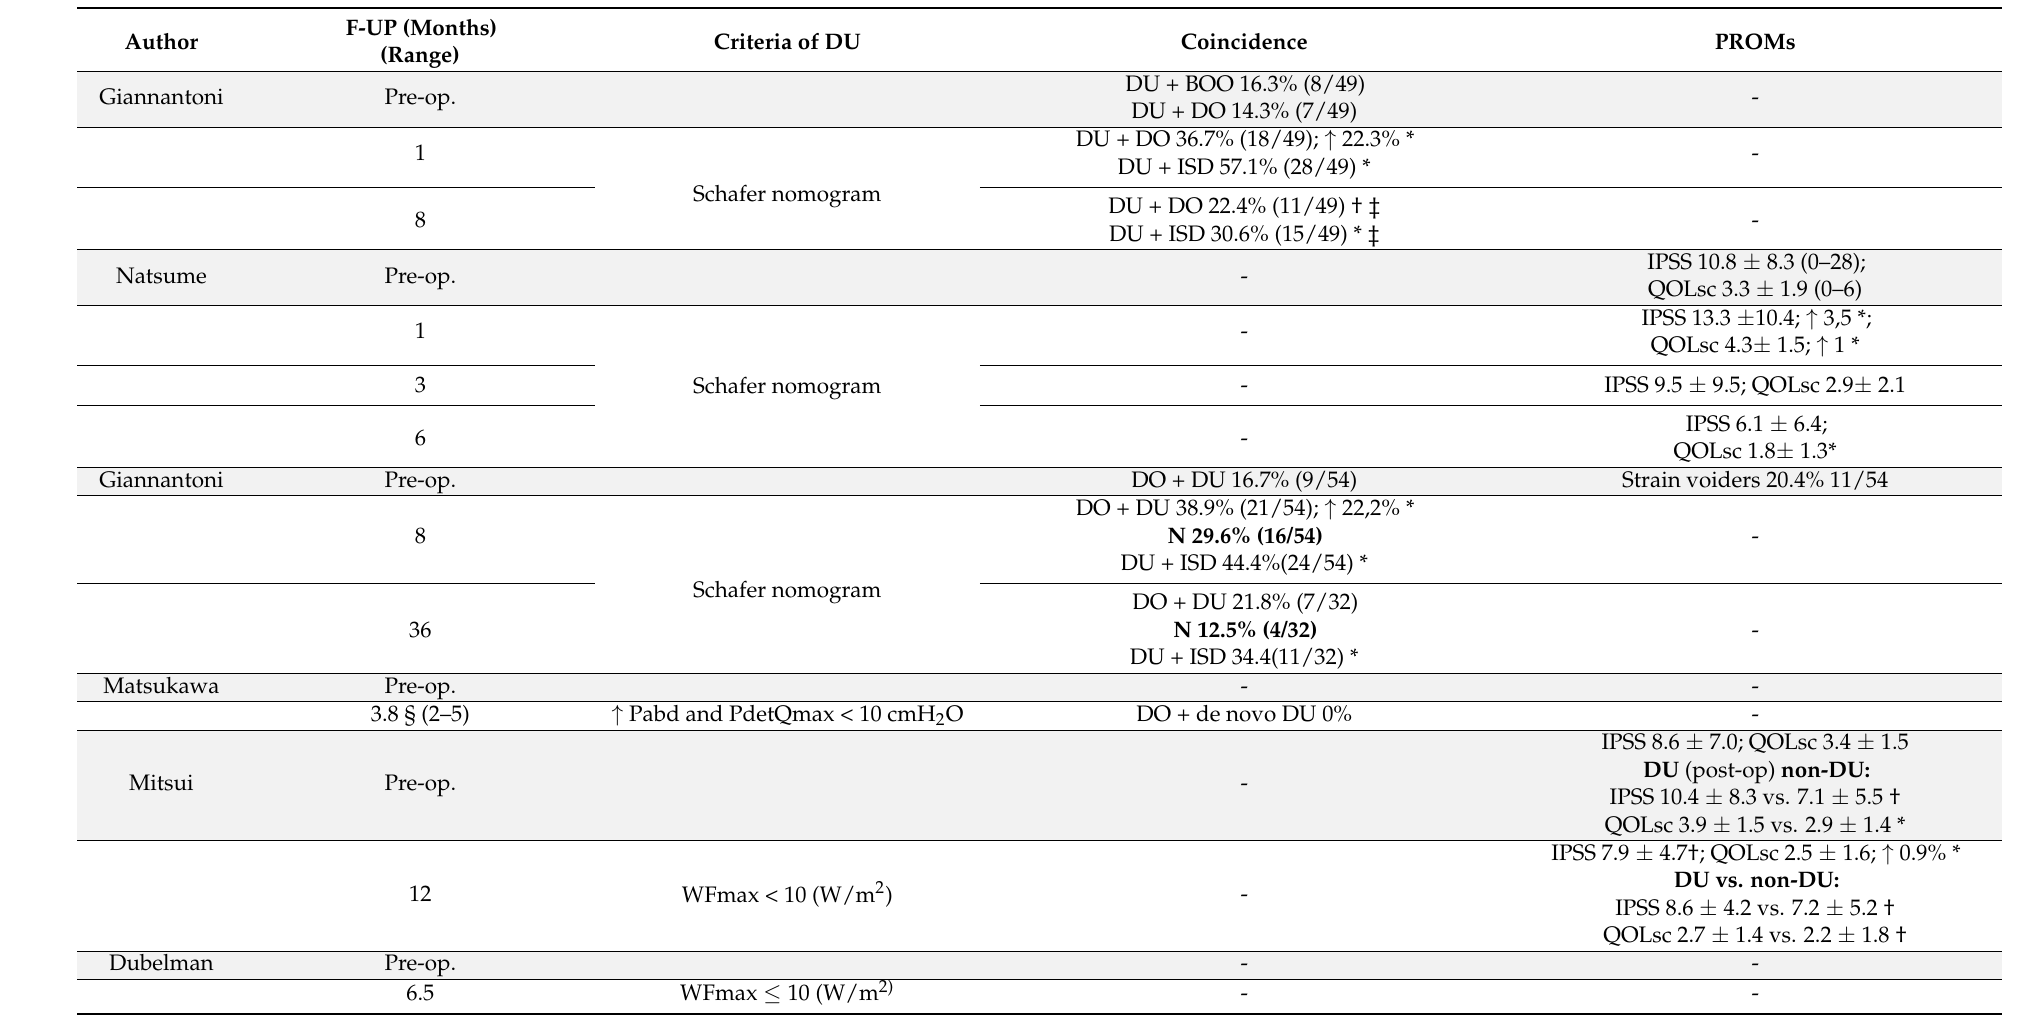
Table 3. Characteristics of studies reporting